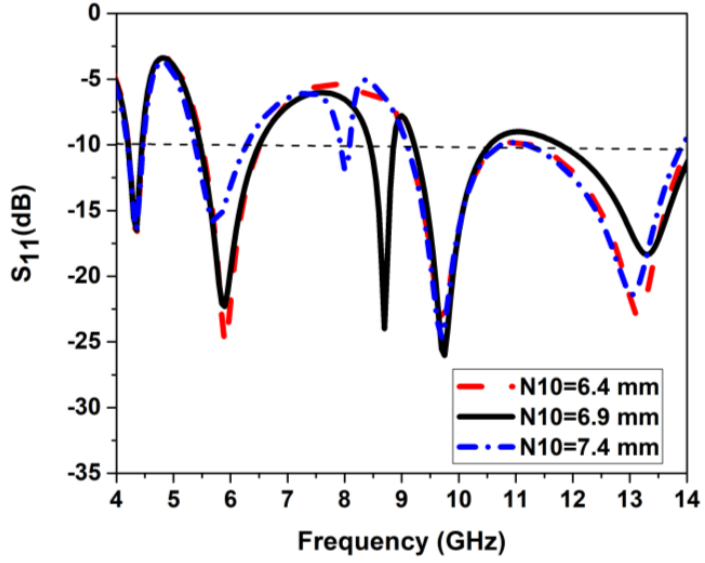
Figure 20. S 11 for variation of length ‘N10′ .